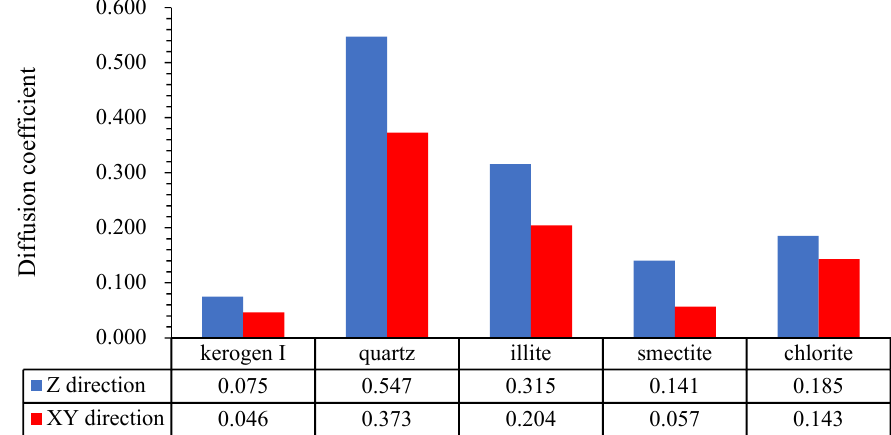
Figure 5. Diffusion coefficient of different minerals. Table 2. Free Volume of pore model for several minerals.